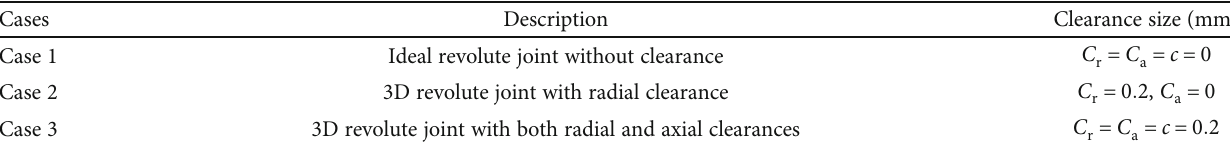
Table 3: Di ff erent case studies of 3D revolute clearance joint.